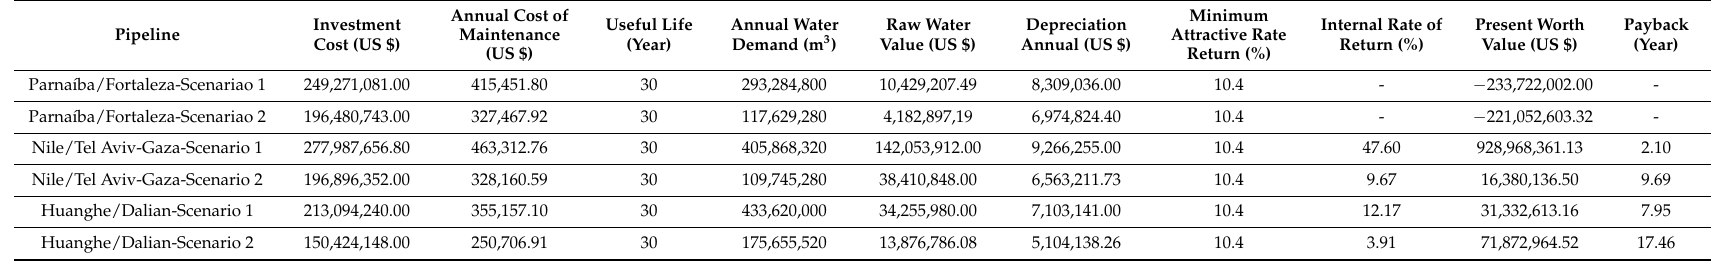
Table 17. Economic Analysis for underwater adductors.